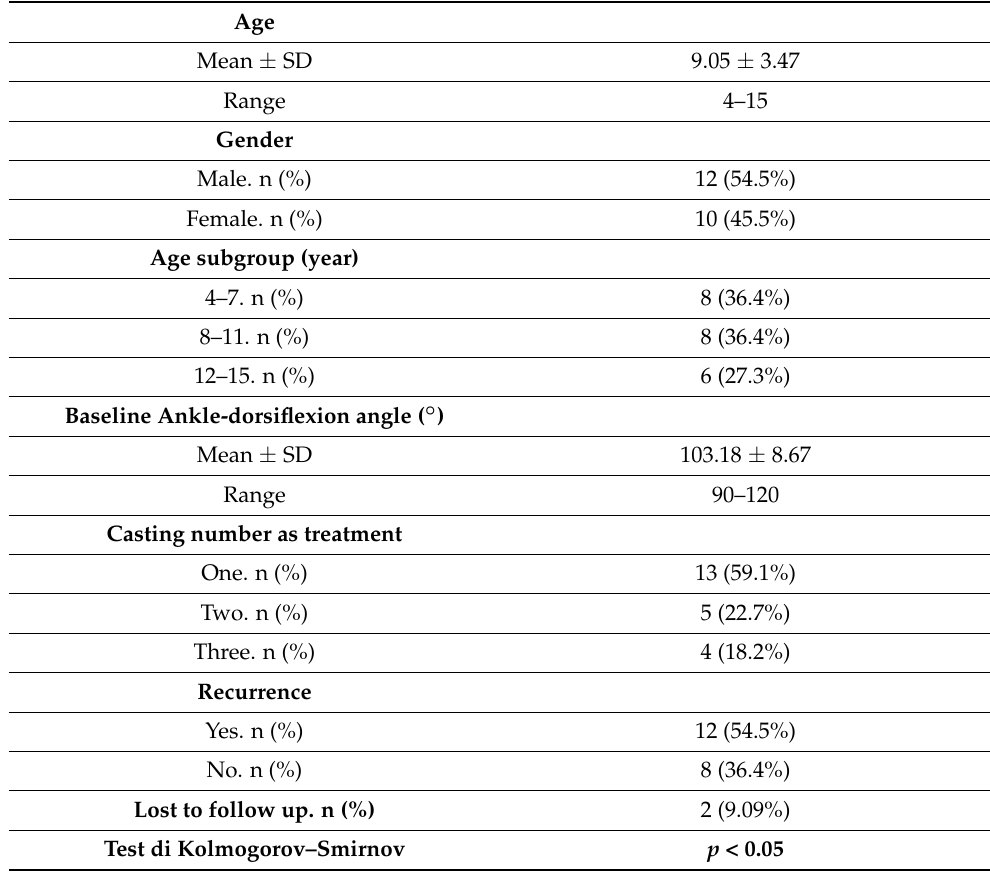
Table 1. Main data of the